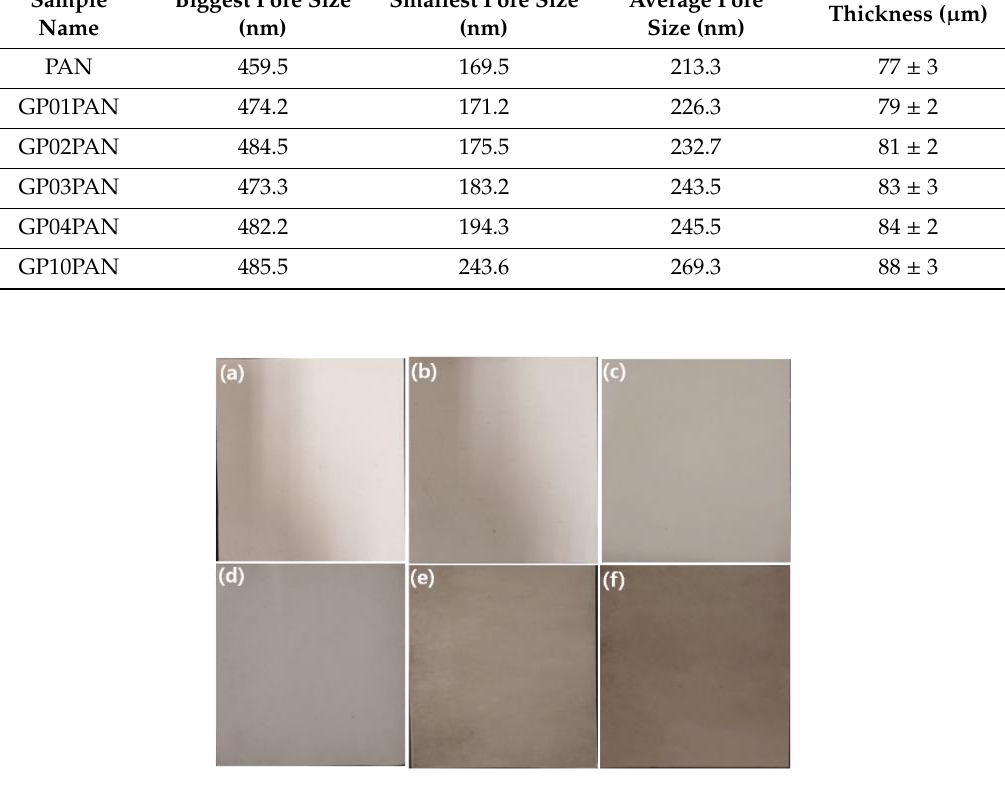
Figure 4. Digital photos of polyacrylonitrile (PAN), graphene oxide modified by polydiallyldimethylammonium chloride/polyacrylonitrile (GP/PAN) hybrid nanofiber membranes; ( a ) PAN nanofiber membrane, ( b ) GP01PAN, ( c ) GP02PAN, ( d ) GP03PAN, ( e ) GP04PAN, ( f ) GP10PAN.